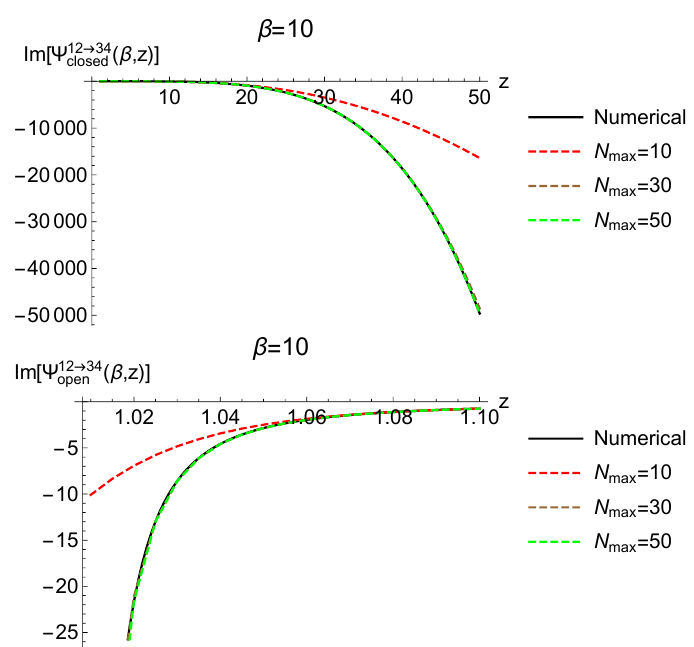
( β , z ) in z → ∞ and closed